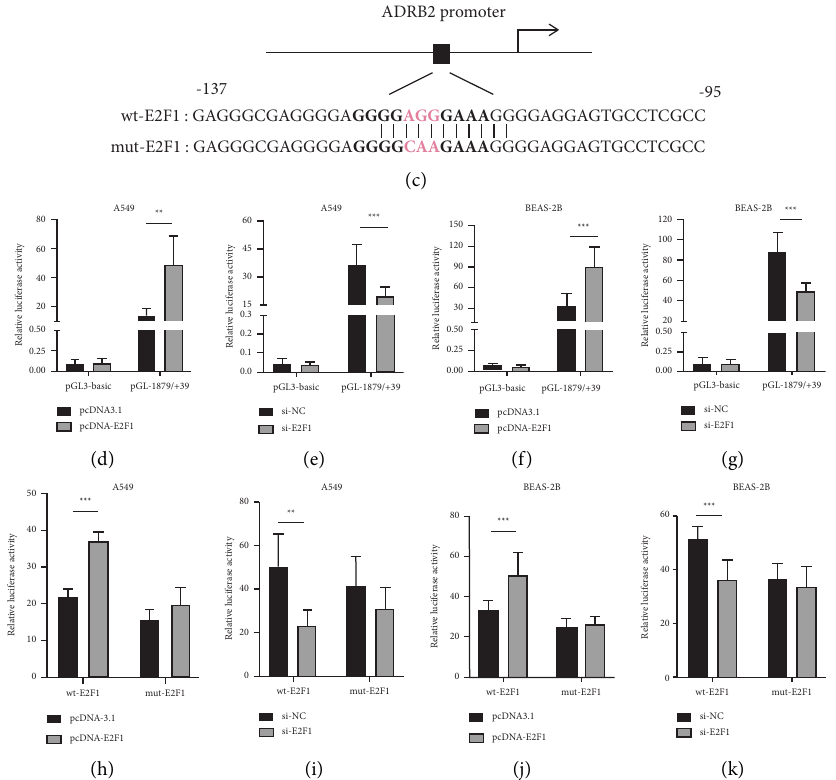
Figure 2: (a) Prediction of binding sites of E2F1 using JASPAR. (b) Phylogenetic conservation analysis of the E2F1 binding sites on human ADRB2 gene promoter. (c) Te mutation of the putative binding site E2F1 on the human ADRB2 promoter around 130bp. (d–g) Regulation of ADRB2 promoter activity by E2F1 in A549 and BEAS-2B cells. Te change of E2F1 level did not afect the activity of the pGL3-basic empty vector. Te pGL3-basic or pGL-1879/+39 plasmids were cotransfected with pcDNA3.1 (100ng) or pcDNA-E2F1 (100ng) into A549 (d) and BEAS-2B (f) cells. Luciferase activity was detected 24h following transfection ( ∗∗ P < 0 . 01, ∗∗∗ P < 0 . 001). At the same condition, the pGL3- basic or pGL-1879/+39 plasmids were cotransfected with si-NC (100nM) or si-E2F1 (100nM) into A549 (e) and BEAS-2B (g). Luciferase activity was detected 24h following transfection ( ∗∗∗ P < 0 . 001). (h–k) Equal amounts of reporter plasmids of human ADRB2 promoter containing wild or mutant E2F1 sites were cotransfected with plasmids of E2F1 overexpression or knockdown into A549 ((h) ∗∗∗ P < 0 . 001,